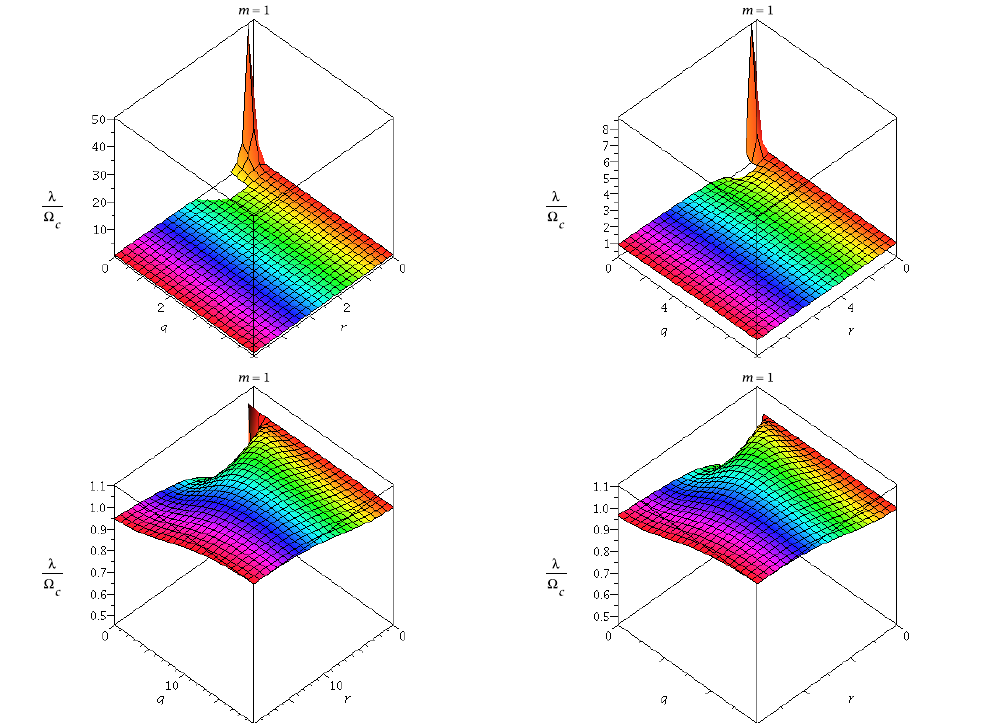
Figure 12. The figure depitcs the variation of λ Ω